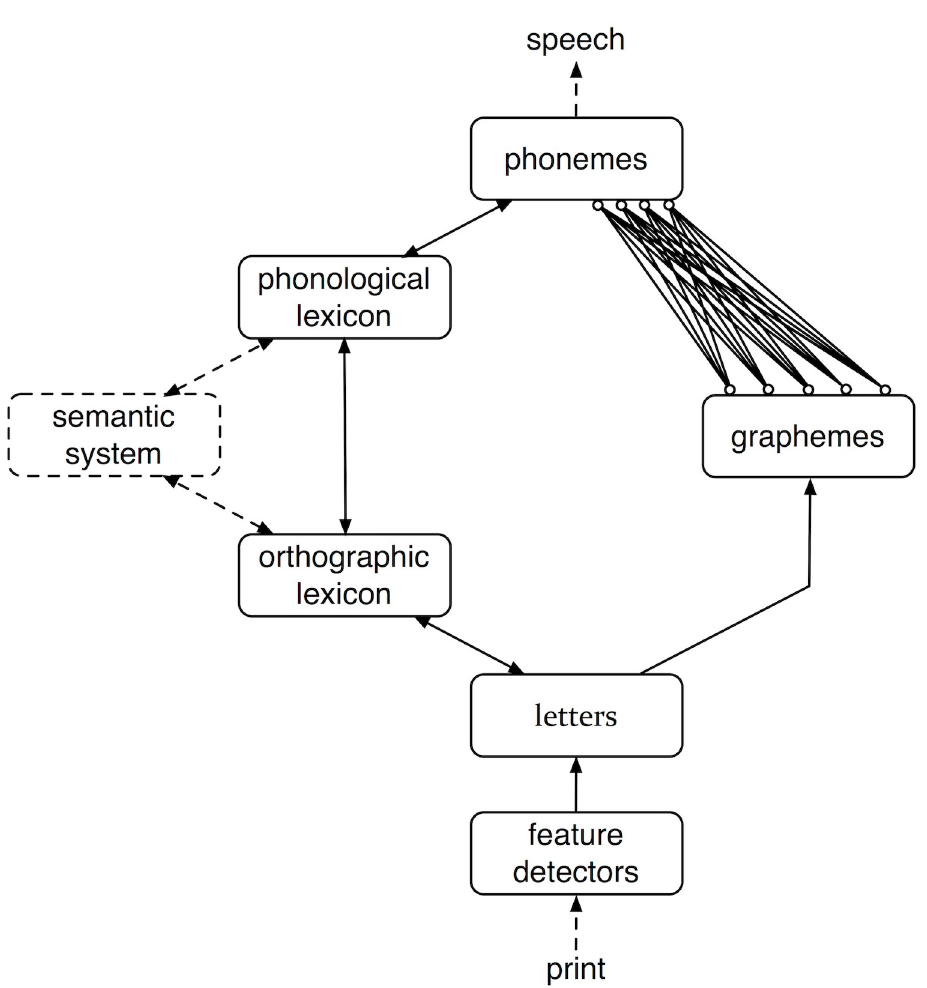
Fig 3. CDP model. Basic architecture of the Connectionist Dual Process (CDP)